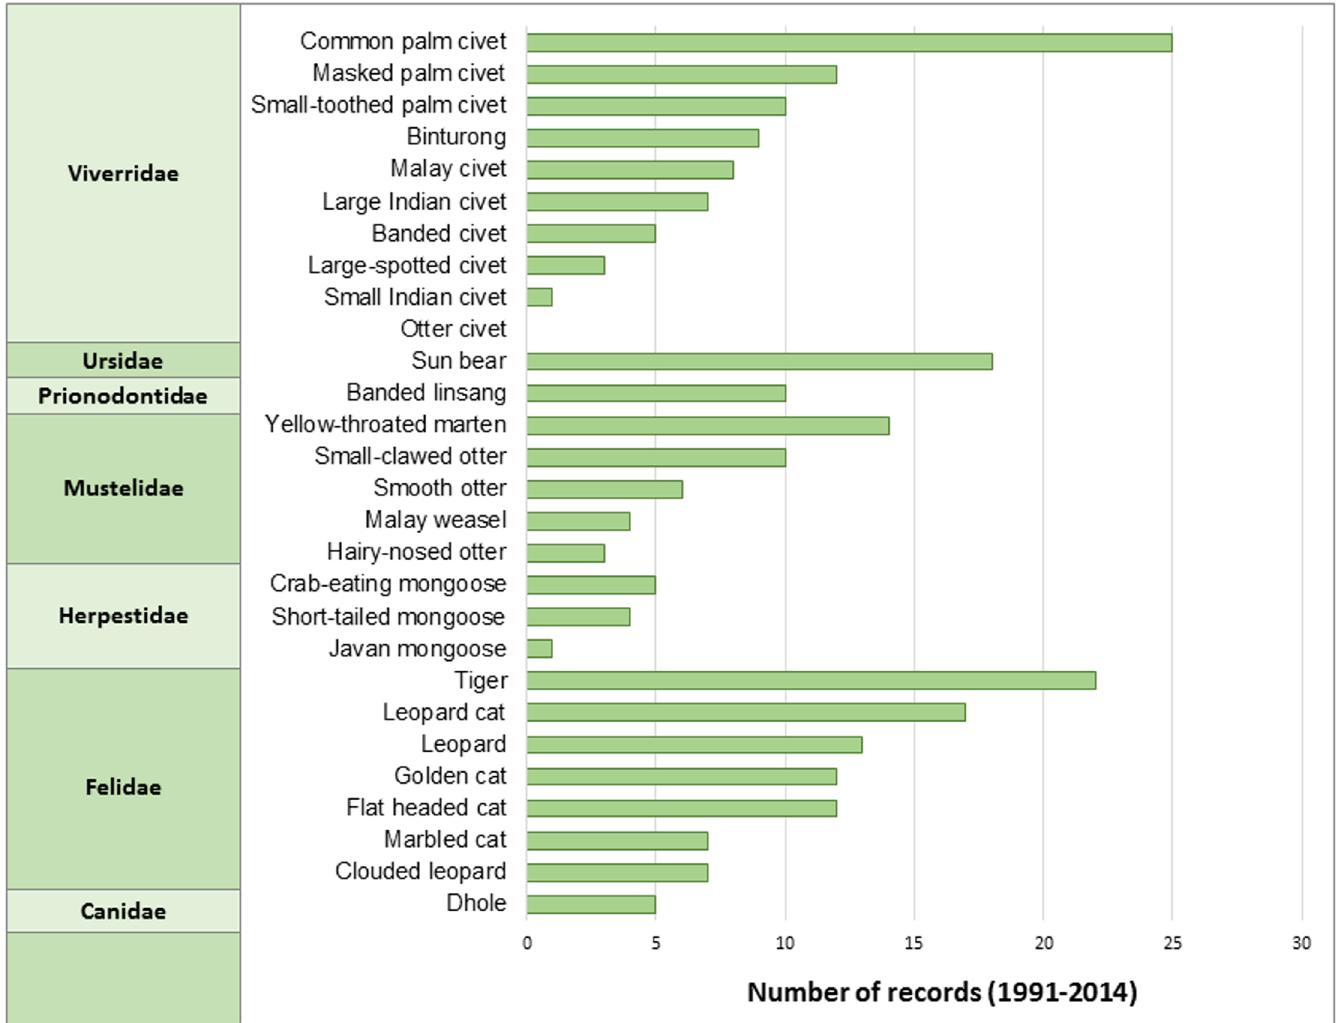
Fig 3. Number of records of Carnivora species in Peninsular Malaysia. Data were obtained from surveys that used conventional trapping, direct observation, sign, remote cameras, or road kills collected during 1991–2014. Species are grouped by family and ranked by number of